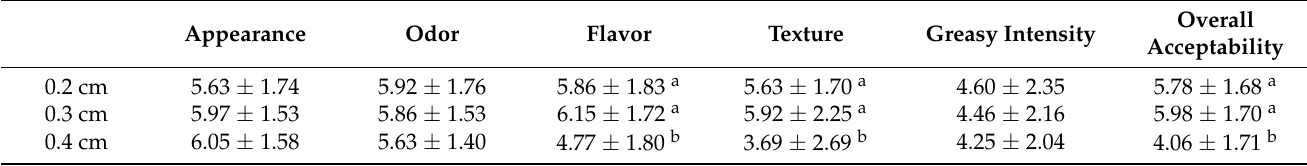
Table 5. The scores of sensory evaluation with fried pork skin under different thickness.